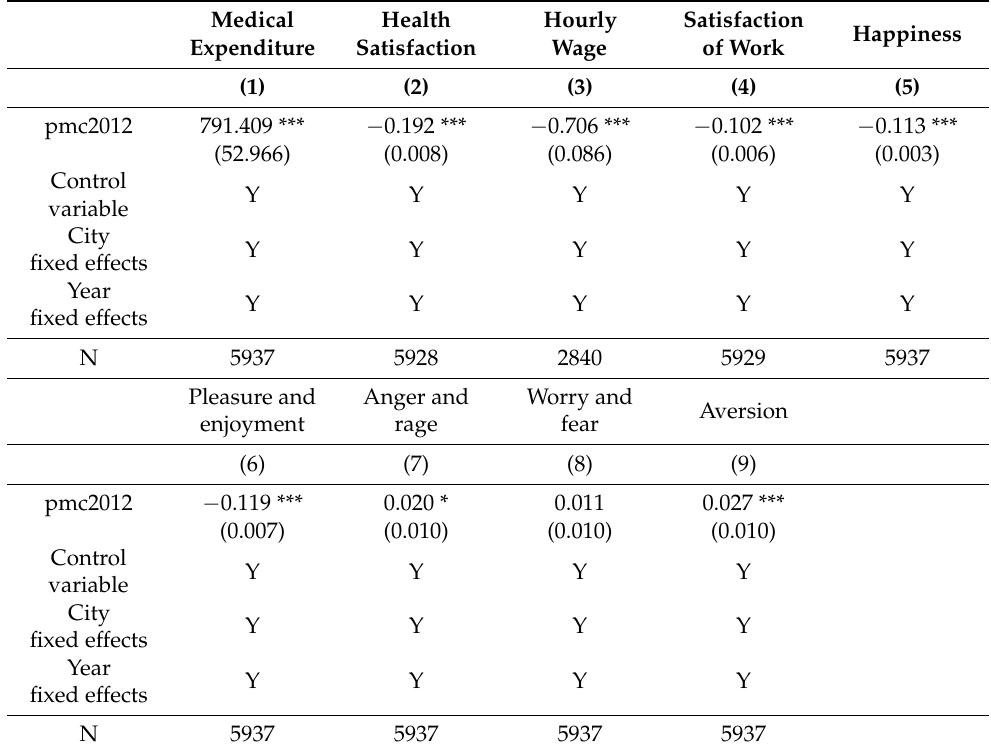
Table 10. Human capital mechanism